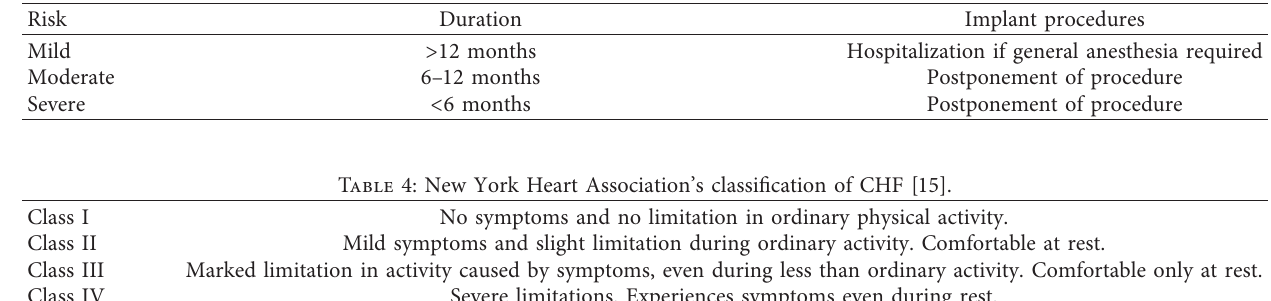
Table 3: Implant considerations in patients with MI based on the duration of last MI attack [4].